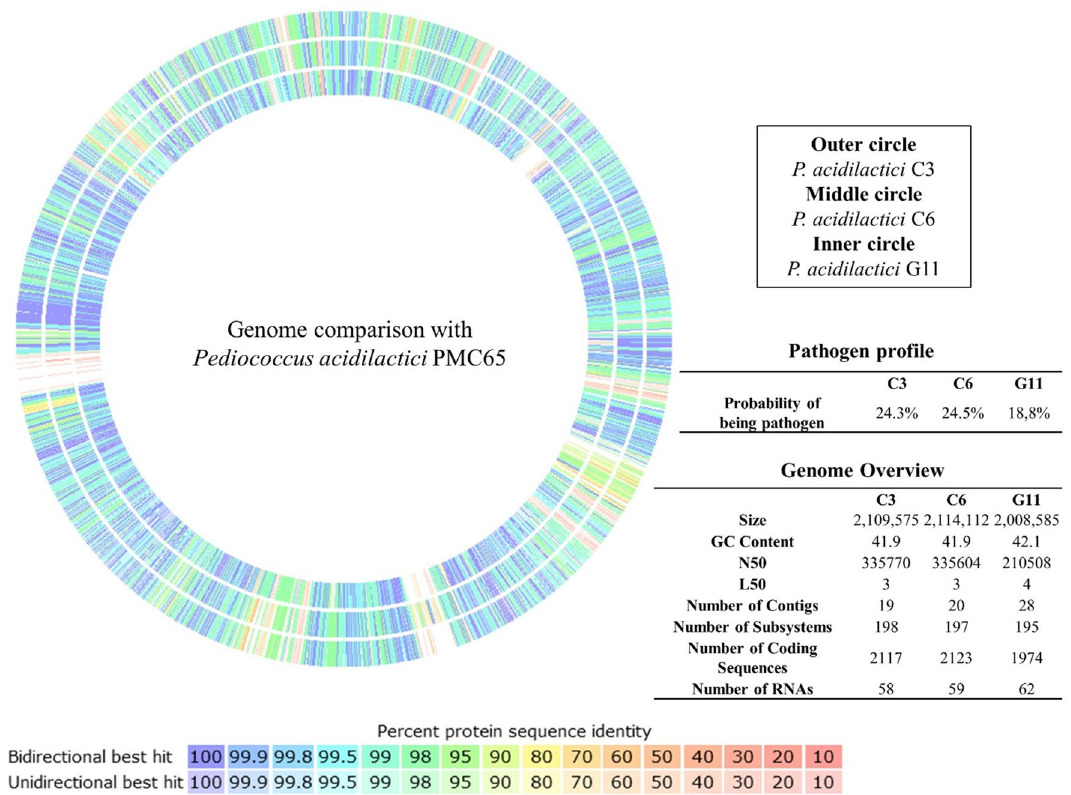
Figure 2. Genome content and Pathogen profiles of 3 Pediococcus acidilactici strains (C3, C6, G11). Genome comparison of C3, C6 and G11 strains showing protein sequence identities with reference strain PMC65 represented in circular